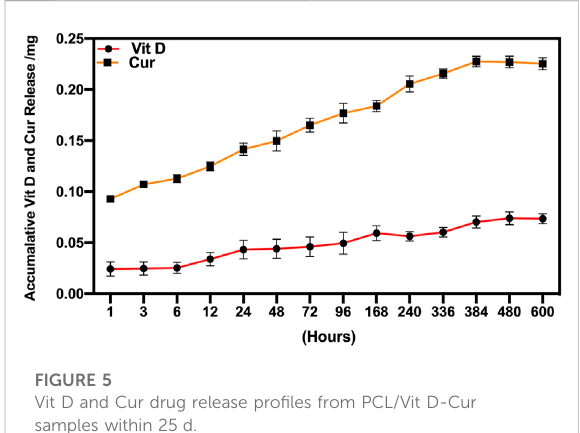
FIGURE 5 Vit D and Cur drug release pro fi les from PCL/Vit D-Cur samples within 25